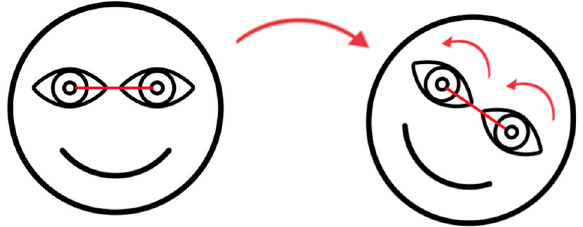
Fig. 1 Visual representation of the ocular counter-roll (OCR). The OCR tends to rotate the eyes in the opposite direction of the head roll. For example, when a head roll to the right is performed, the eyes will rotate to the left as a compensatory re fl